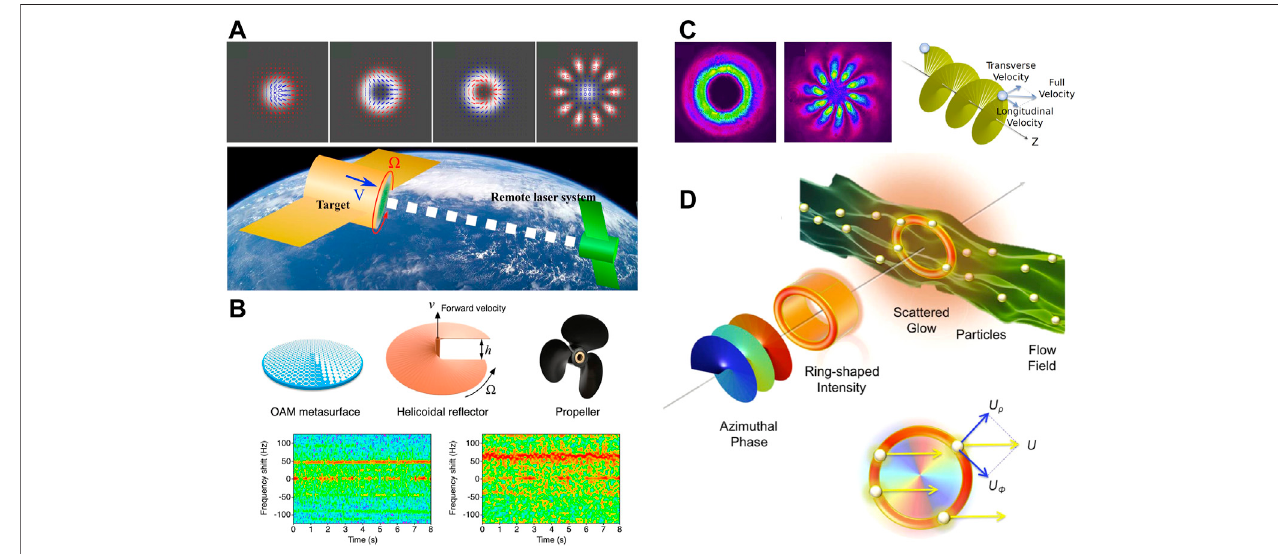
FIGURE 4 | Compound motion detection by RDE of structured light. (A) In-suit detection ofa cooperative target ’ s longitudinal and angular speed using structured light[66]. (B) Experimental observation oflinear and rotational Doppler shiftfrom severaldesigner surface [67]. (C) Measuring the translational and rotational velocitiesof particles [38]. (D) Measurement of fl ow velocity with helical beams of light